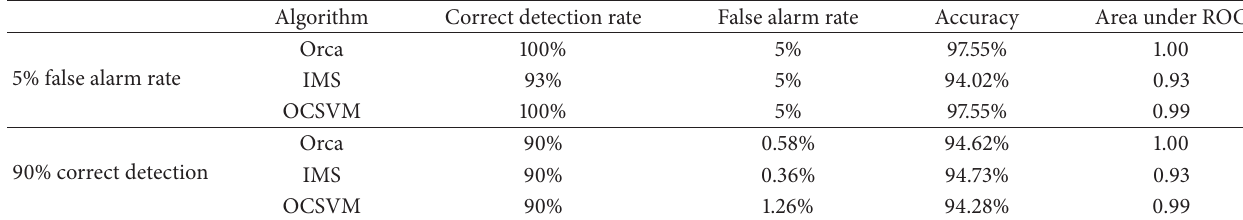
Table 1: Multiple 10000 rpm cycle test